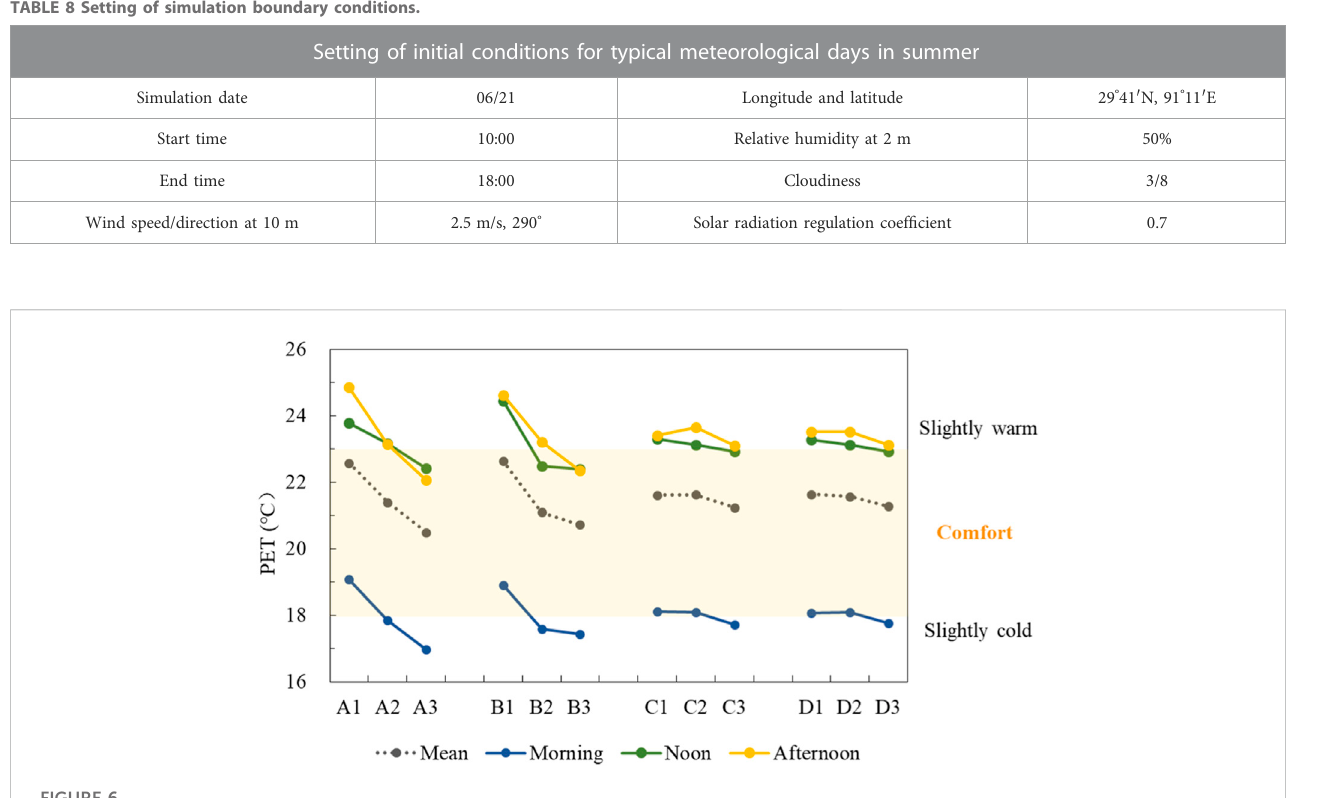
TABLE 8 Setting of simulation boundary conditions.